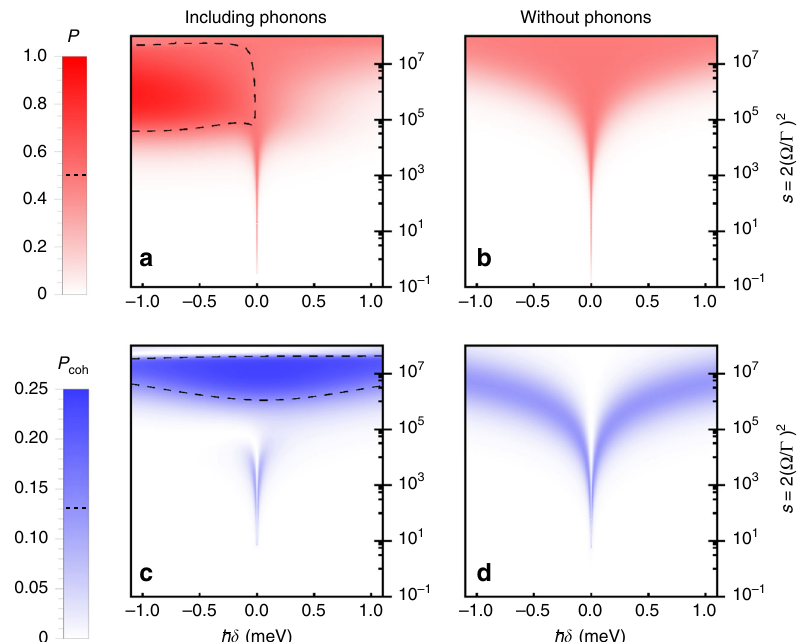
Fig. 1 Resonance fl uorescence power contributions. Normalised total emission power P with ( a ) and without ( b ) phonons, and coherently scattered power P s = 2( Ω / Γ ) 2 ] and detuning. Comparing the cases with and coh with ( c ) and without ( d ) phonons, plotted as functions of the scaled driving strength [ without phonons we see markedly different behaviour at large driving strengths. The dashed contour lines indicate half the maximum possible value for P max ¼ 0 : 5 and 1 P max ¼ 0 : 125, neither of which are exceeded in the absence of phonons. Parameters: each power contribution from a two-level-emitter, 1 2 2 coh ζ = 0.027ps 2 , ω = 2.2 ps − 1 , T = 4 K, and 1/ Γ = 700 c